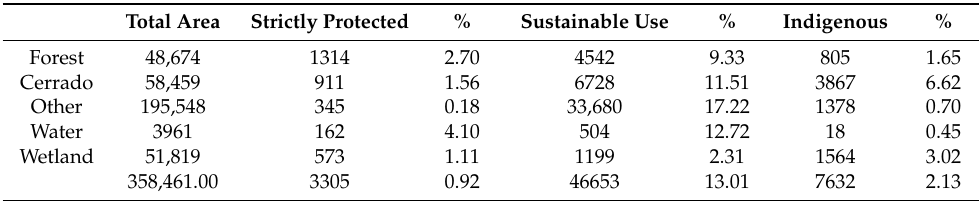
Table 2. Landscape area within protected and indigenous areas (km 2 ).